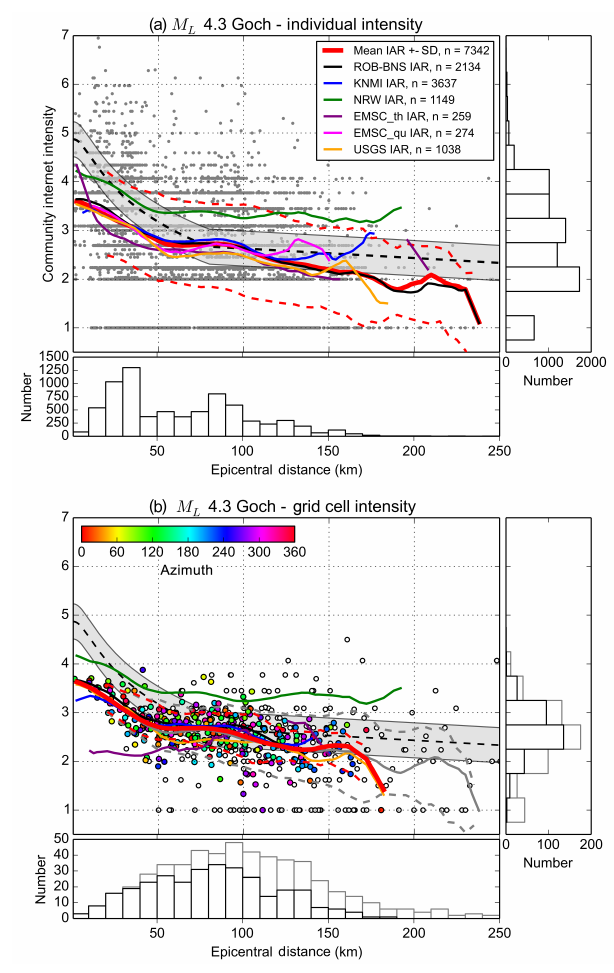
Figure 7. Intensity attenuation of the 2011 Goch earthquake. The horizontal and vertical histograms show the number of intensity distance points binned per 10km and per half-intensity unit, respec- tively. Black line indicates CEUS-predicted intensities using Atkin- son and Wald (2007) for an M w 3.7. The intensity attenuation re- lations (IARs) are smoothed with a moving bin technique, with a bin window length of 20km and overlapping steps of 2km. IARs in (a) are derived from individual agency data sources and from all merged individual IDPs (red line). (b) IARs are derived from grid cell centroid intensity data (red: cells >two responses; grey: all cells; other colours: see legend in (a) ) after merging macroseismic datasets of all institutes (except NRW-GD). Colours represent the azimuthal position of the grid cell centre (centroid) relative to the seismic source. SD: standard